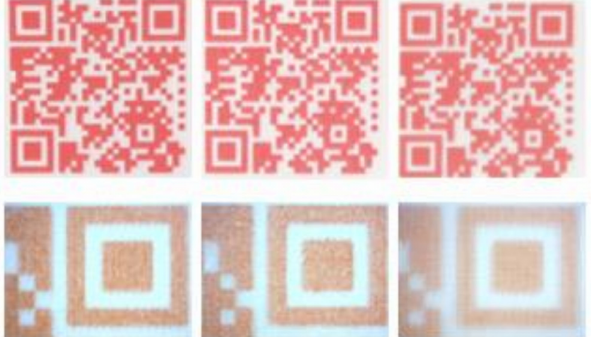
Figure 3. QR codes with 0.75 mm cell size printed with the thermochromic ink on different substrates: from left copy paper, label and photo paper. Pictures are taken with a camera ( above ) and with microscope ( below